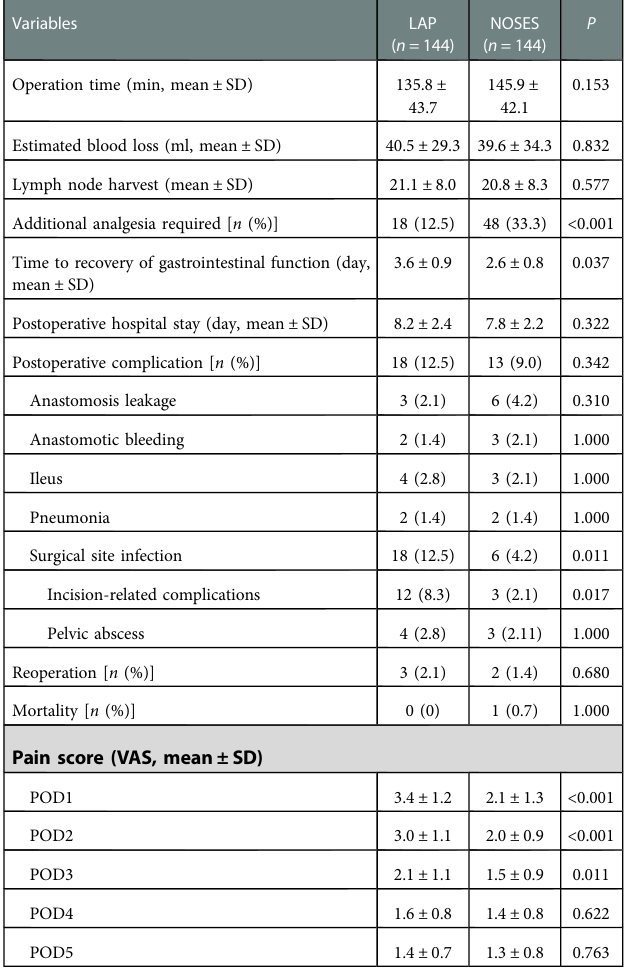
TABLE 2 The perioperative outcome of patients in the NOSES group and LAP group.